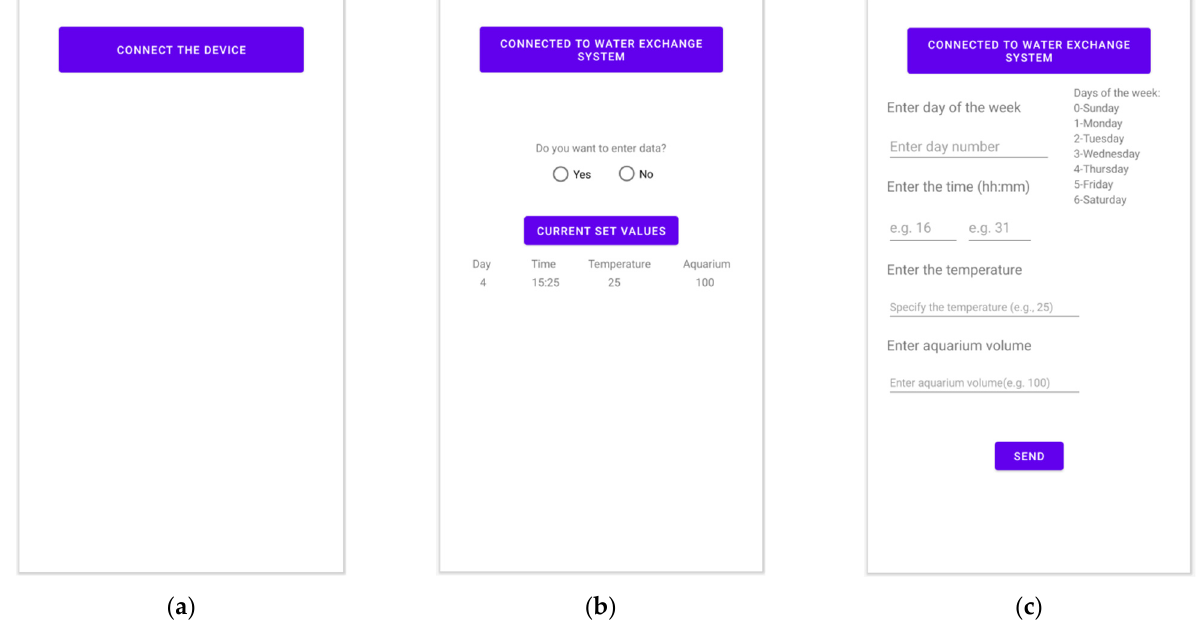
Figure 8. Mobile application: ( a ) mobile application start screen; ( b ) mobile application connection screen; ( c ) data entry screen .